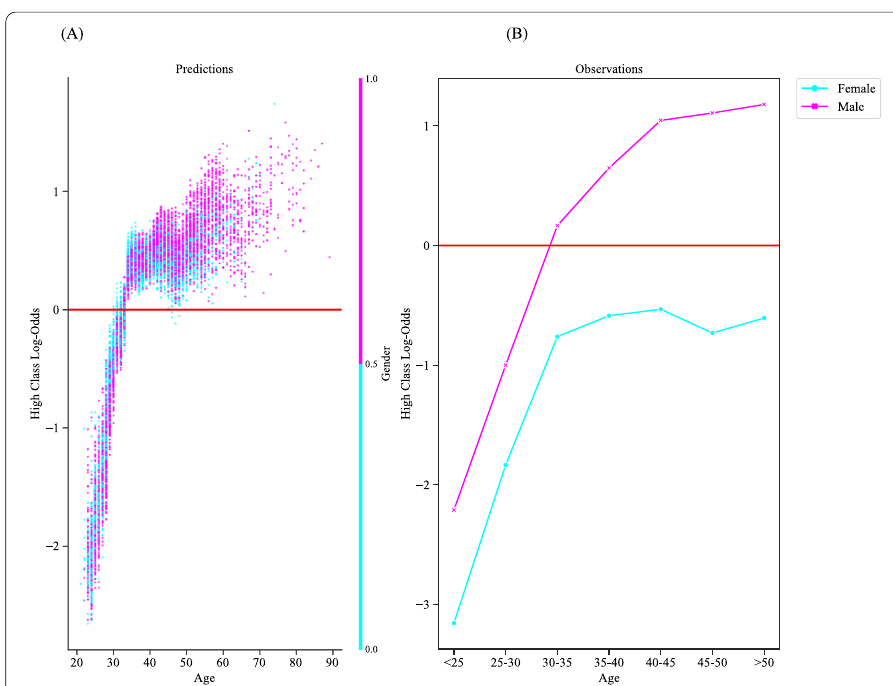
Fig. 17 Gender and Age SHAP dependency plot of the gradient boosting model, where A are the predictions and B are the